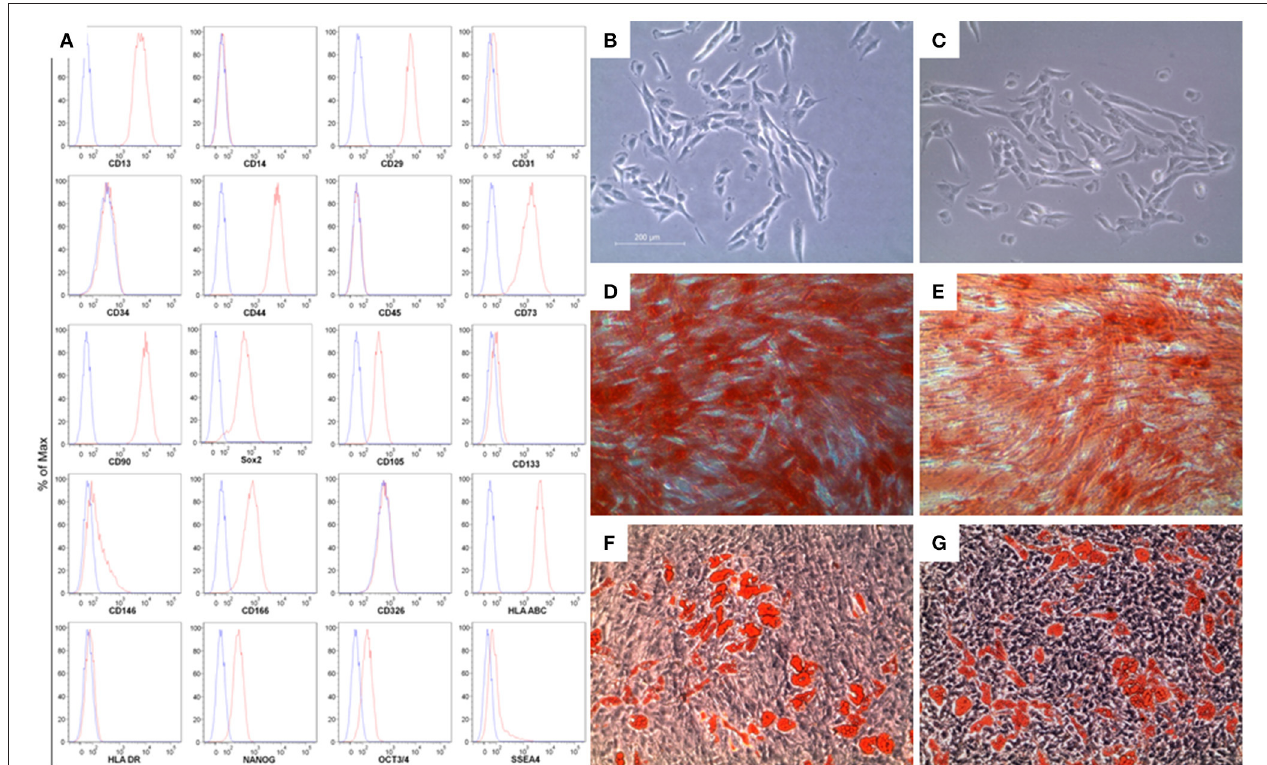
FIGURE 1 | Characterization of gingiva-derived mesenchymal stem cells (hGMSCs). (A) Flow cytometry phenotype of hGMSCs at the second passage during in vitro cultures of surface (CD13, CD14, CD29, CD31, CD34, CD44, CD45, CD73, CD90, CD105, CD117, CD133, CD146, CD166, CD326, HLA-ABC, and HLA-DR) and intracellular (SSEA4, Oct3/4, Sox2, and NANOG) marker expression levels were detected. Red histograms show the distribution of each antigen expression, whereas Blue histograms represent the distribution of the respective background control. (B) The gingival connective tissue-derived mesenchymal stem cells showed colony-forming potency and plastic-adherent characteristics at day 6. (C) CBD-hGMSCs and CTR-hGMSCs showed spindle-shaped, fibroblast-like morphology under light microscope. (D) Osteogenic differentiation at day 21 after Alizarin Red S staining highlighted calcium deposits in CTR-hGMSCs and in (E) CBD-hGMSCs. (F) CTR-hGMSCs and (G) CBD-hGMSCs induced to a dipogenic differentiation after 28 days showed many oil droplets at cytoplasmic level stained with Oil Red O solution. Mag: 10X; bar: 200 µ